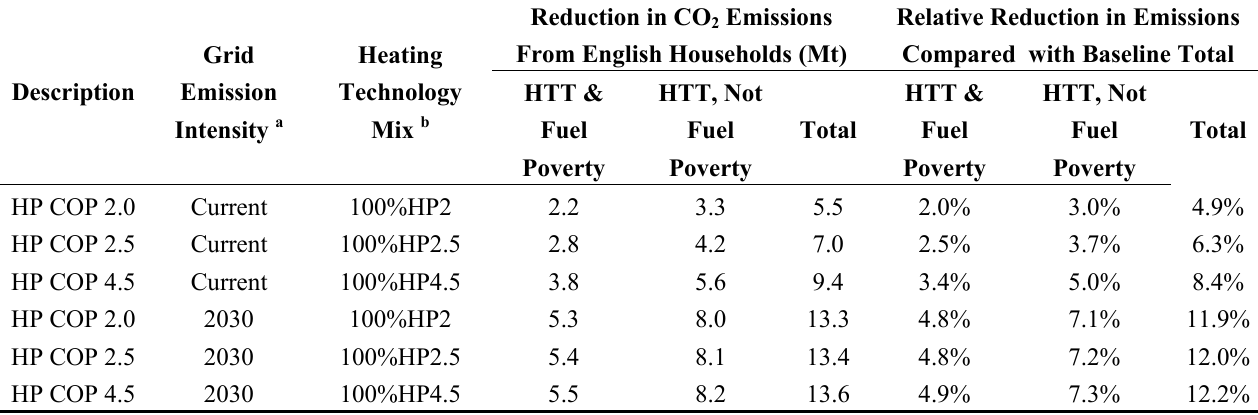
Table 9. Annual emission reductions resulting from a phased heat pump installation strategy for all electrical resistive heated homes—phase 1 in fuel poverty, phase 2 the